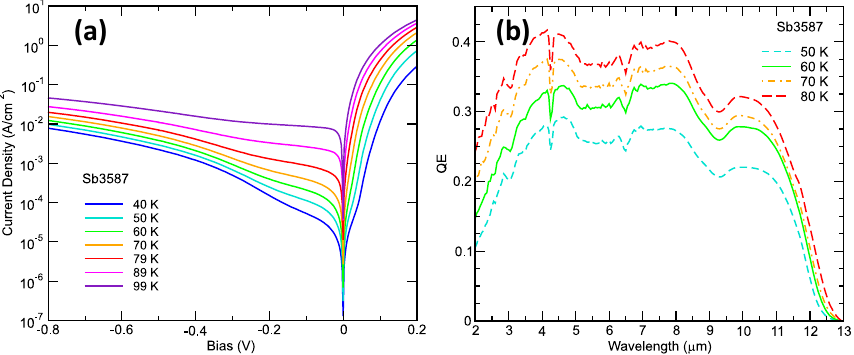
Figure 6. ( a ) Dark current density as a function of applied bias, measured at several temperatures, and ( b ) backside illuminated spectral QE, for a pn-CBIRD detector fabricated from sample Sb3587.